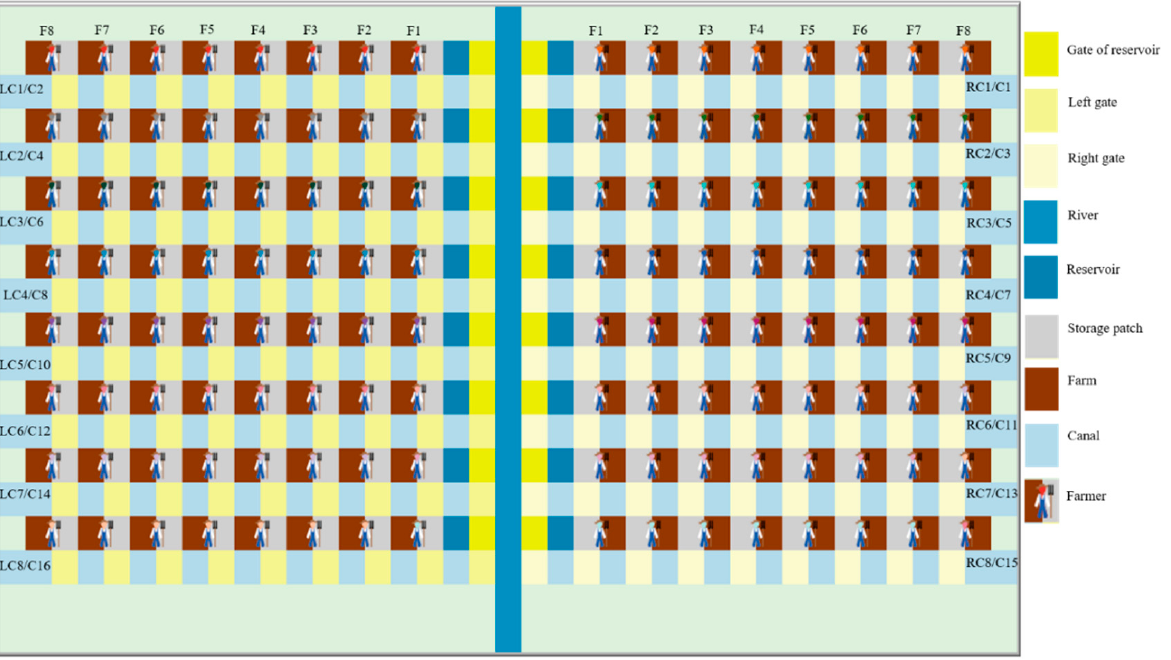
Figure 2. The layout of the artificial irrigation system. Note: RC-the right canal, LC-the left canals, C-canals, F-farmers, number- the ID of each farmer and canal, the higher the number, the more downstream the farmer/canal.